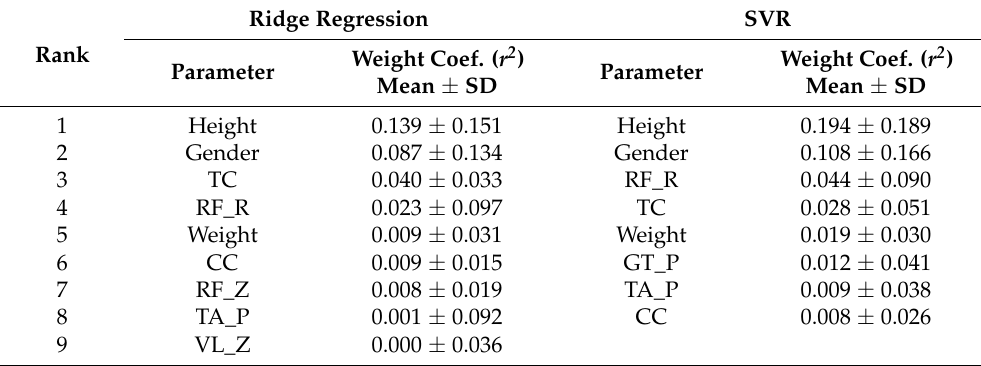
Table 4. The ranks and weight coefficients of parameters under the RR and SVR models by the RFE